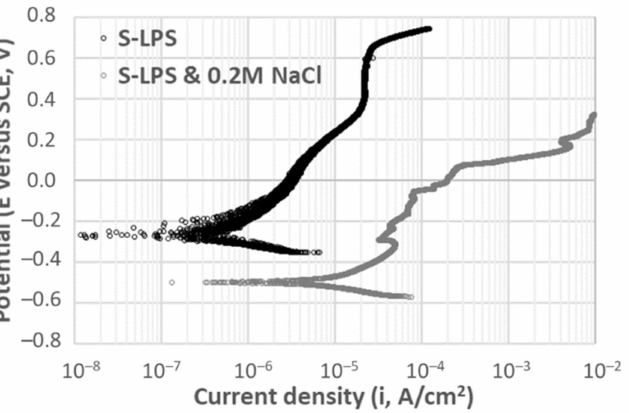
Figure 8. Anodic polarization curves of sand blasted steel (S) in leachate pore solution without (in black) and with 0.2 M NaCl (in